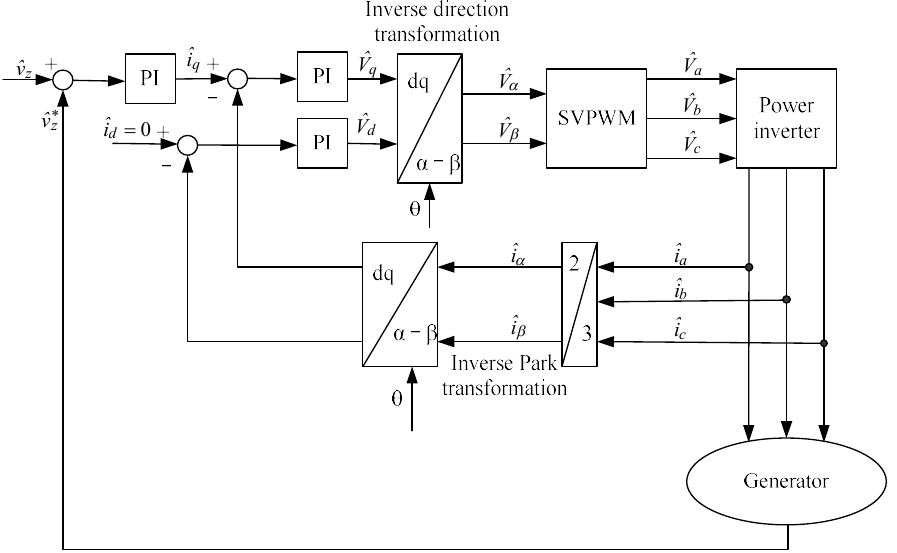
Figure 10. Optimization control diagram of ocean wave power generation system based on the q -axis current of generator.